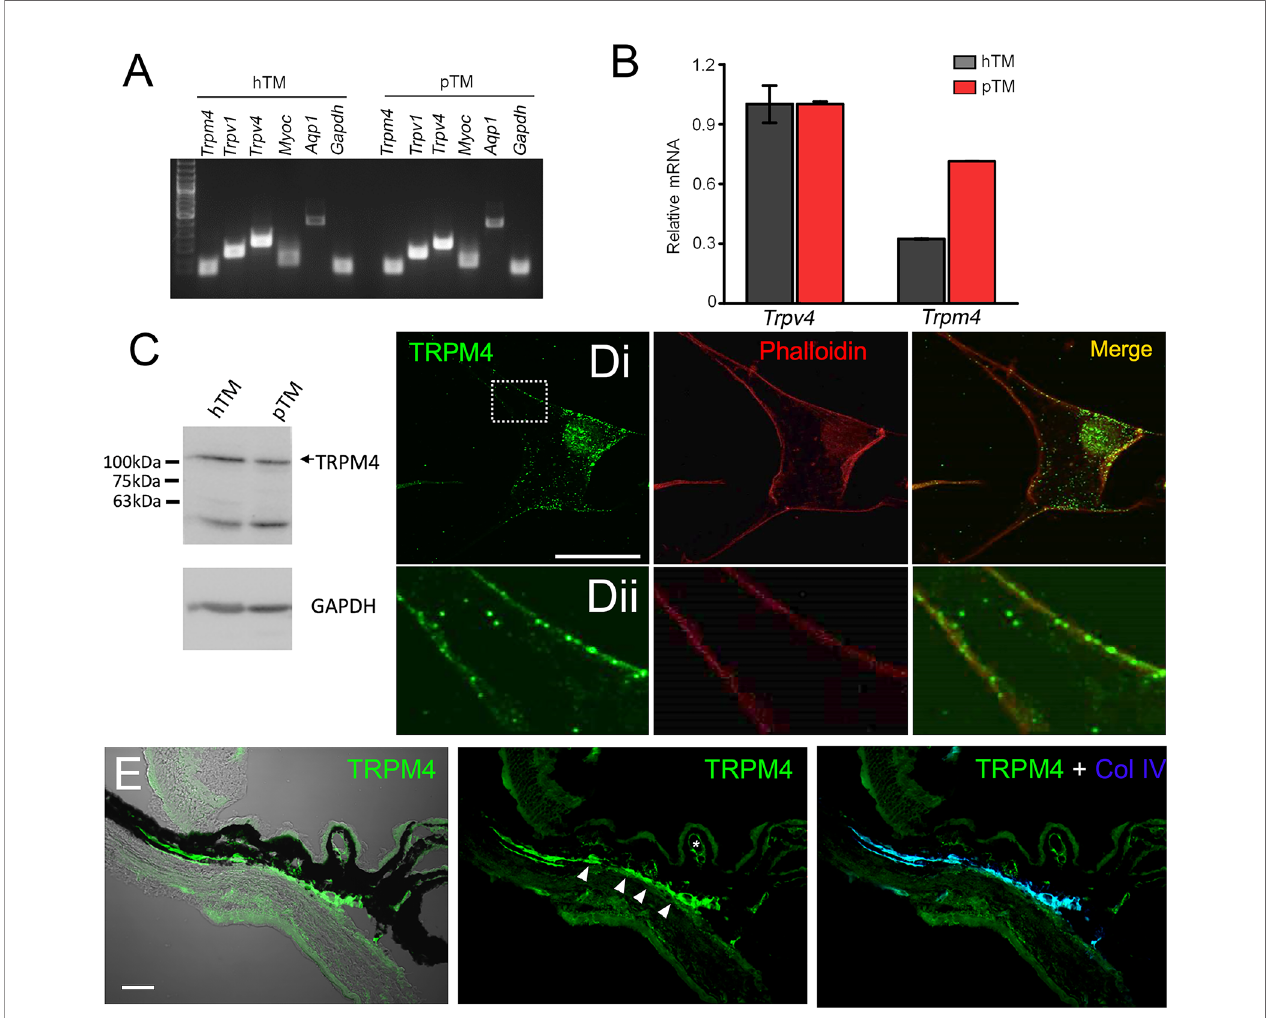
FIGURE 5 | TRPM4 is expressed in TM cells. (A) Representative PCR gels show expression of TRPM4 and TRPV4 transcripts together with markers aquaporin 1 (AQP1), TRPV1, and myocilin (MYOC) in immortalized (hTM) and primary (pTM) cells. (B) Semiquantitative qRT-PCR. Relative mRNA abundance of TRPM4 vs. TRPV4; expression is normalized to hTM TRPM4; mean ± S.E.M, N = 3. (C) Western blot. hTM and pTM cells show a TRPM4 band at the expected M.W. [ (D) , upper panel] Cultured cells immunolabeled for TRPM4, with a magni fi ed image of the region selected by the square ( inset ) showing punctate signals within